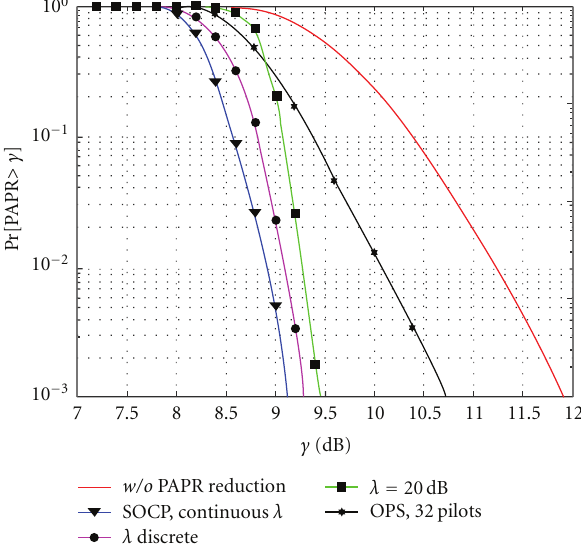
Figure 11: CCDF comparison in two cases: λ = 20dB and discrete λ , with OPS technique [4],